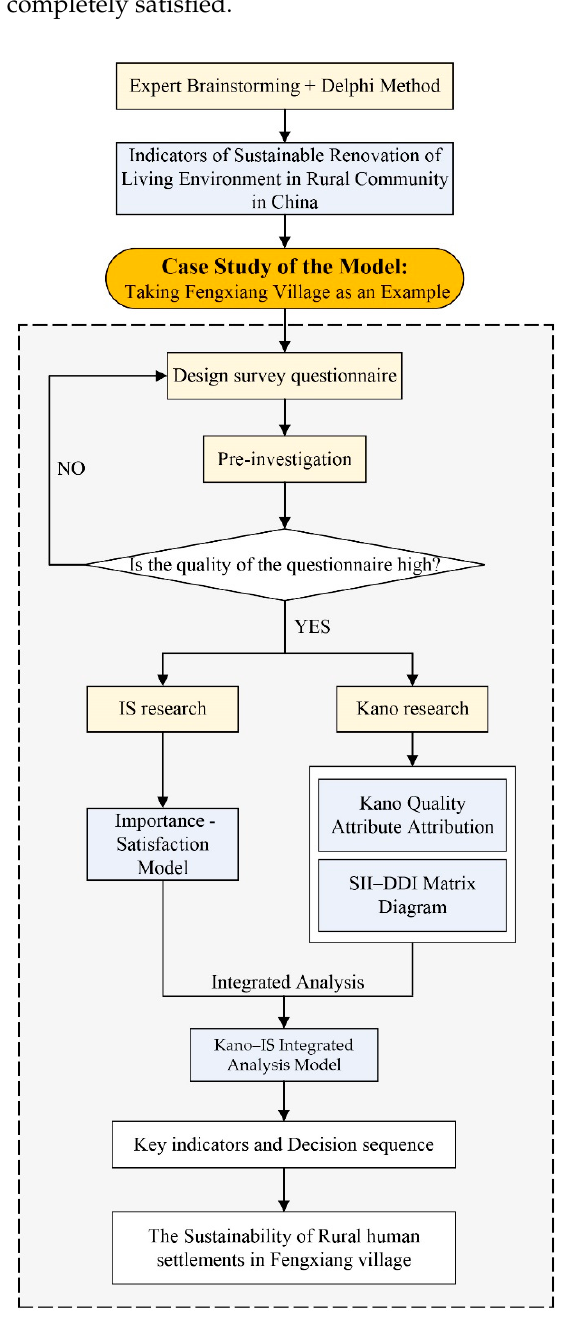
Figure 3. Research Figure 3. Research framework.